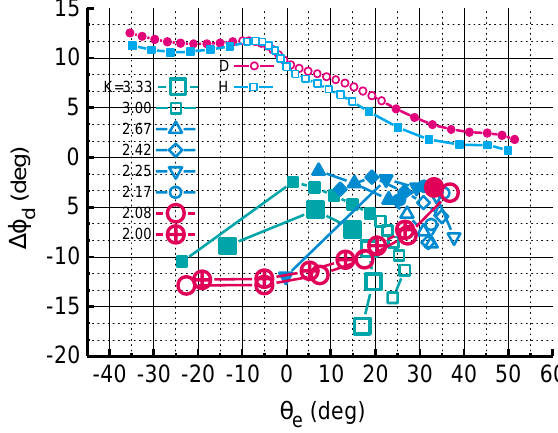
FIG. 8. (Color) Dependence of beam direction on its exit point. To measure a beam direction angle, w d , the origin of the co- ordinate system in Figs. 1 and 4 is translated from the cy- clotron center to a beam exit point. The results are expressed as Dw d (cid:1) w d 2 (cid:4) 1.125 u e 2 31.25 (cid:5) in order to make the dif- ference between curves corresponding to different K more pro- nounced. Unlike ´ 2 , the direction angle of a negative ion beam (D 2 and H 2 ) depends on u e and therefore must be considered during extraction system optimization. For positive ion beams, the represented data points correspond to the same set of test beams whose values of ´ 2 are shown in Fig. 7. As in Fig. 7, solid symbols on data points depict beams with foil position placed over a sector, while open symbols correspond to foil po- sitions in the valley. The smaller the angular spread of beams in an exit point, the narrower the corresponding range of the bending magnetic field necessary for the adjustment of beam directions to the transport line direction.